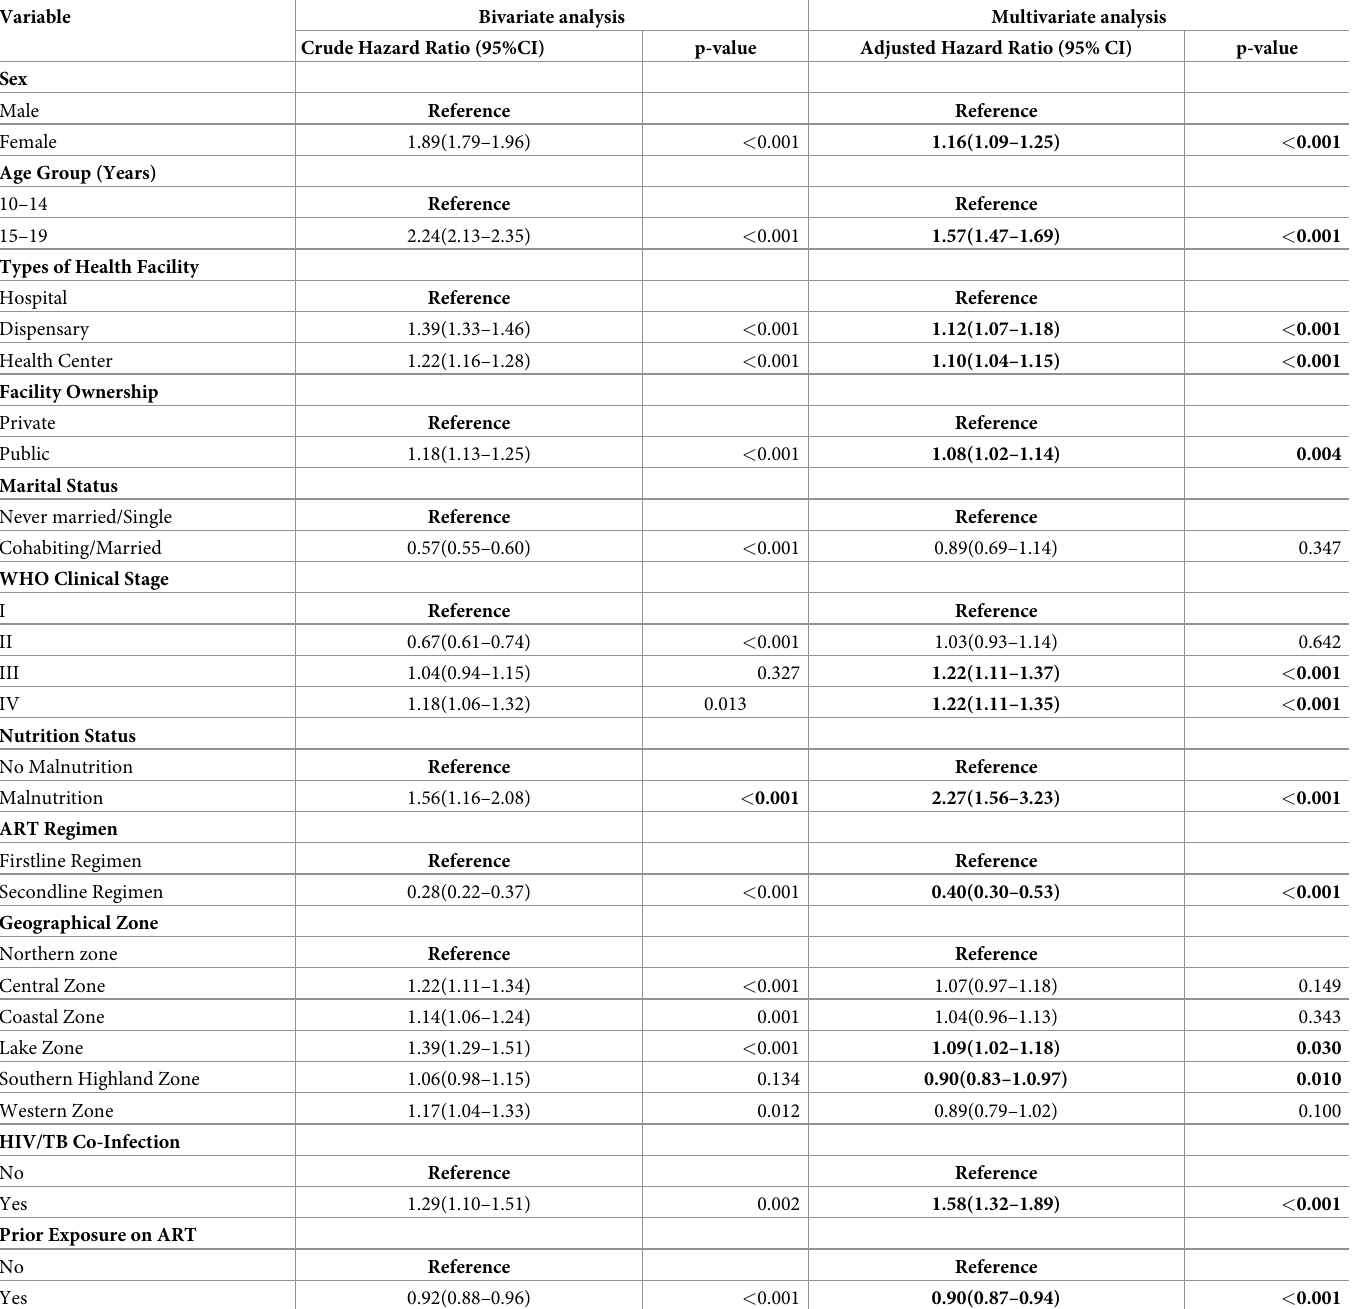
Table 3. Bivariate and multivariate analysis of loss to follow up among adolescent on